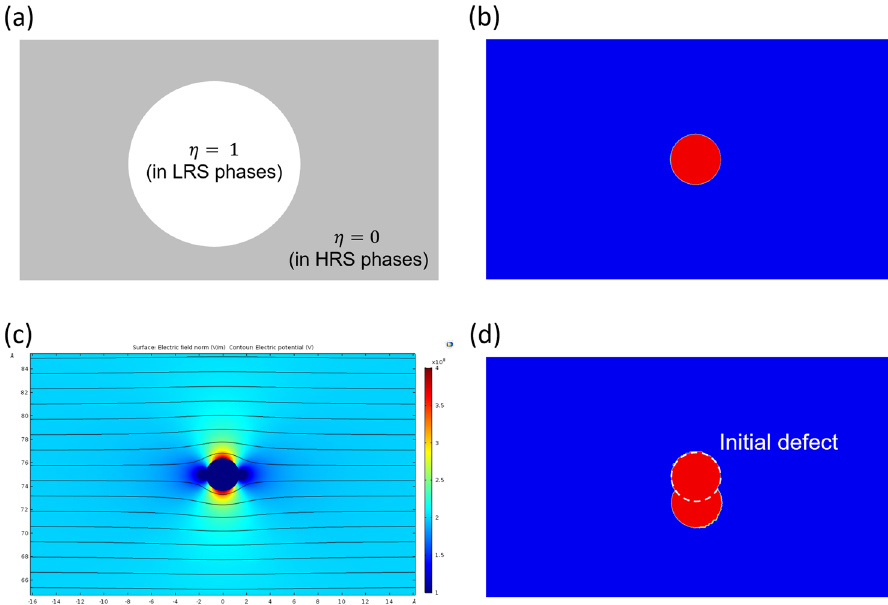
Figure 1. Representation of our simulation system and electric-field-dependent defect generation: ( a ) value assignment to phase variable η ( (cid:31) r ) for low- and high-resistance phases (LRPs and HRPs, respectively), ( b ) a defect LRP embedded in an HRP matrix, ( c ) electric-field distribution (colored) with equipotential lines, and ( d ) new defect generated below the initial defect